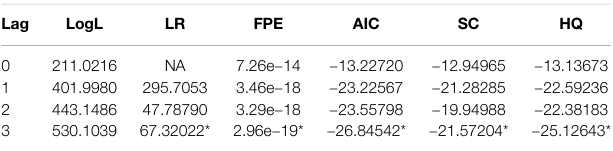
TABLE 3 | VAR optimal lag order selection criteria.